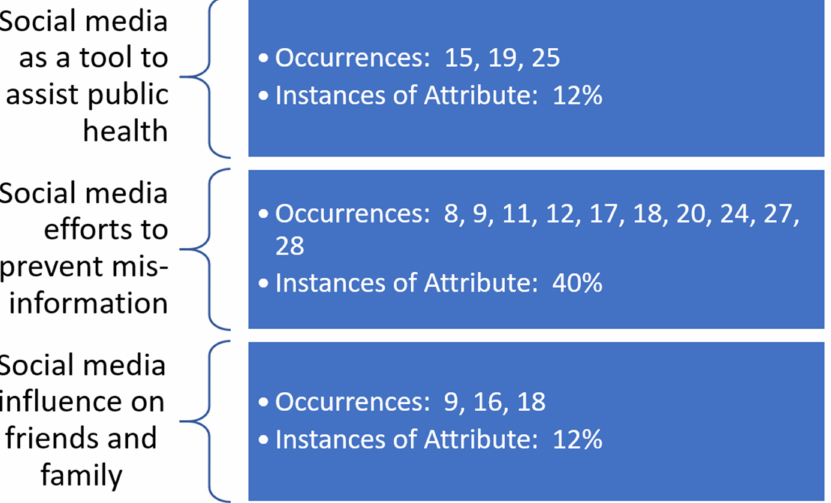
Figure 4. Occurrences of underlying themes identified as facilitators to COVID-19 vaccine promotion in social media as observed in the